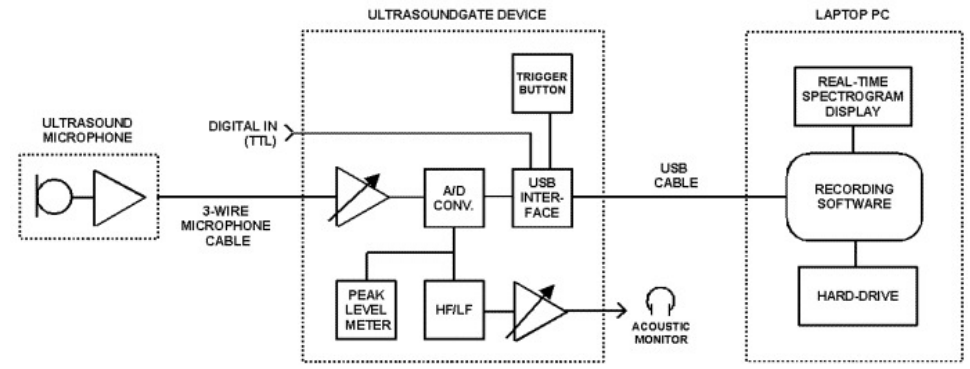
Fig. 2 – Principle of the UltraSoundGate